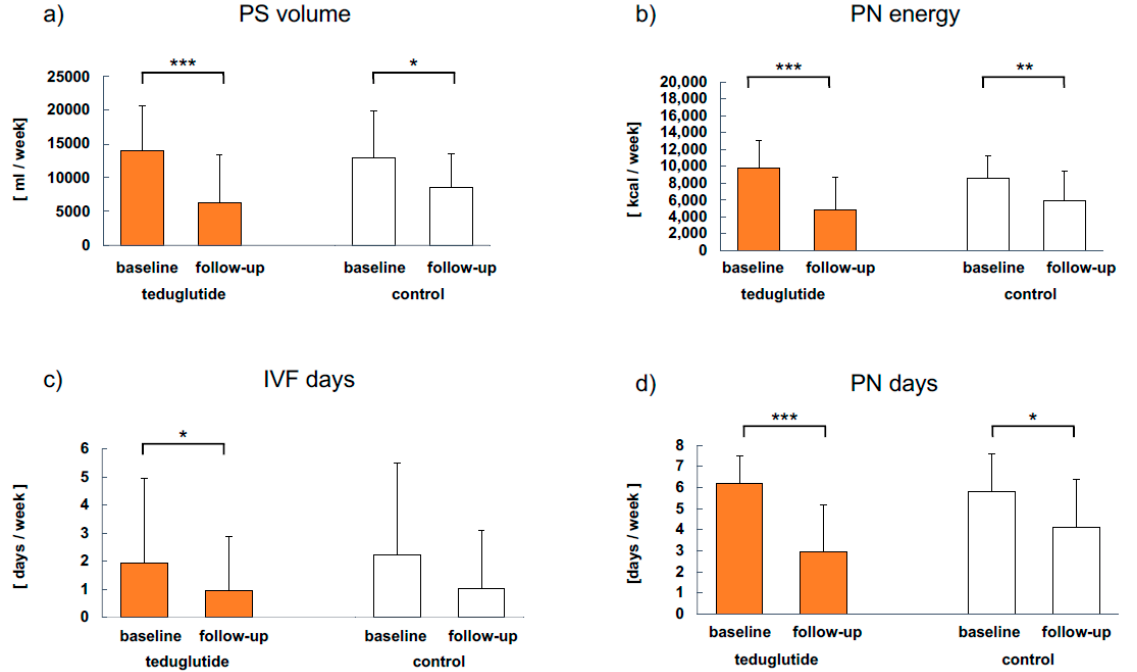
Figure 3. PS characteristics ( n = 17) for teduglutide-treated patients and non-treated controls. ( a